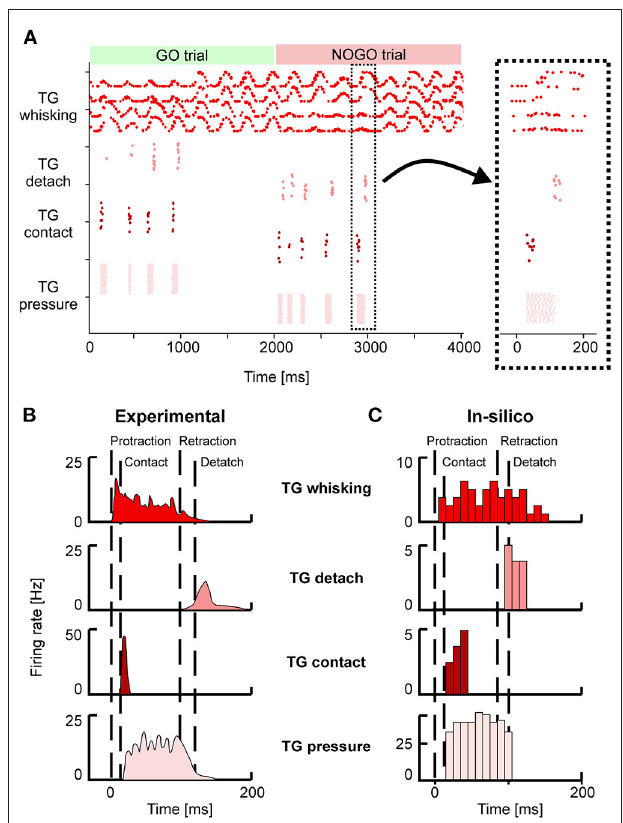
FIGURE 4 | (A) Spiking activity of the Trigeminal Ganglion (TG) neurons during GO and NOGO trials. Each row represents the activity of one neuron, and different shades of red are used to plot the activity of the four groups of TG neurons. The inset shows a magnified portion of the full scatterplot, focusing on a single protraction-retraction movement of the whiskers. (B) Firing rates of TG populations were measured experimentally during a single protraction-retraction movement, as reported in Ahissar and Knutsen (2016). Vertical dashed lines represent the four main events: the start of the protraction, contact of the whisker against an object, the start of the retraction, detach of the whisker from the object. (C) Firing rates were recorded from the simulation of the SNN model of TG populations. The length of each bin is 10 ms. Colors are the same as (A,B) .